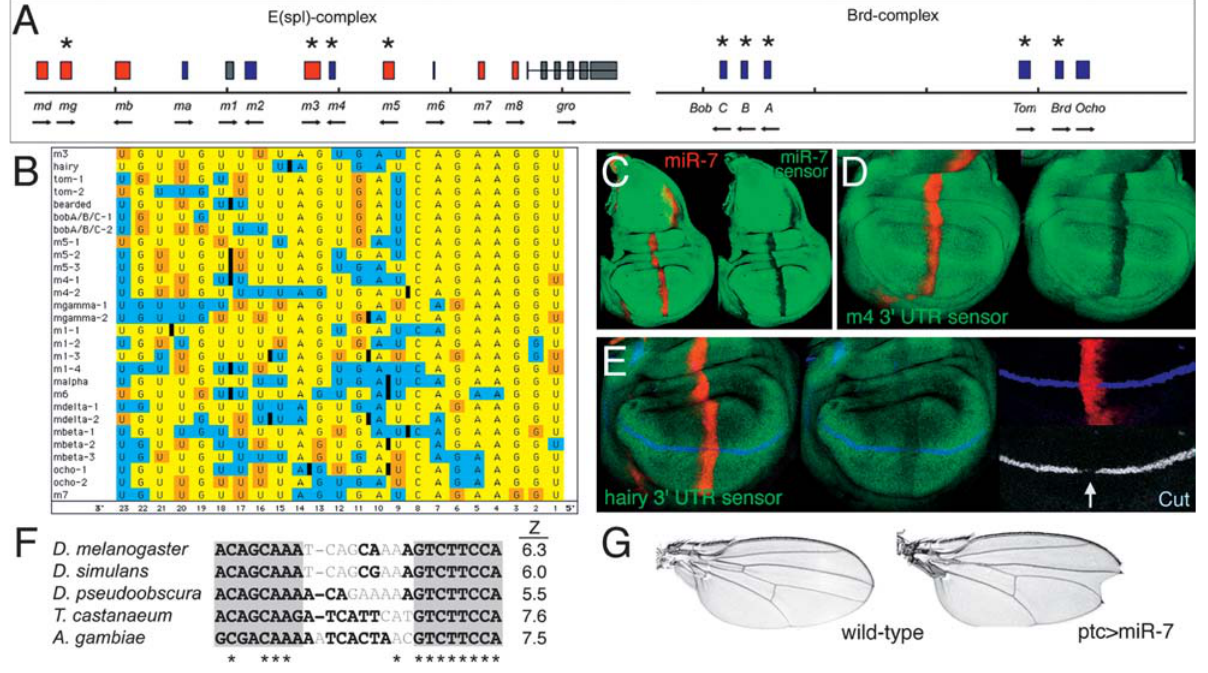
Figure 3. Experimental Validation of miR-7 Targets (A) Schematic representation of the E(spl) and Brd gene complexes, which contain multiple predicted miR-7 target genes. bHLH-type transcriptional repressors are shown in red. Brd-type proteins are shown in blue. Other transcripts in the E(spl) cluster are in gray. Black asterisks indicate sites with no mismatch in the first eight residues (likely to be valid sites). (B) miR-7 miRNA sequence showing the pattern of basepairing with target sites in E(spl) and Brd complex genes sorted in order of predicted folding energy. Yellow indicates a conventional basepair. Orange indicates a G:U basepair. Blue indicates a mismatch. The black bars indicate the position of loops in the target sites. (C) Expression of the miR-7 sensor transgene is shown in green. Expression of the red fluorescent protein miR-7 miRNA under ptc–Gal4 control is shown in red. The right panel shows the miR-7 sensor alone. (D and E) Expression of the m4 3 9 UTR and hairy 3 9 UTR sensor transgenes (green) were downregulated by miR-7 (red). Expression of the hairy 3 9 UTR sensor was much lower than the m4 3 9 UTR sensor overall. Cut protein, shown in blue, was downregulated in miR-7 expressing cells. The right panel shows a second example of Cut repression. The lower panel shows Cut channel alone. (F) ClustalW alignment of miR-7 target sites in the 3 9 UTRs of hairy from several species. Asterisks indicate sequence identity. Black type indicates basepairs by Mfold (including G:U basepairs). Gray shading highlights the conserved miRNA–target binding region in all five species. (G) Cuticle preparations of a wild-type adult wing and a wing expressing miR-7 under ptc–Gal4 control in the region between veins 3 and 4. Note the notching of the wing and the reduction of the region between veins 3 and 4, leading to partial fusion proximally. The size of the posterior compartment was increased apparently to compensate for reduction of the vein 3–4 region. DOI: